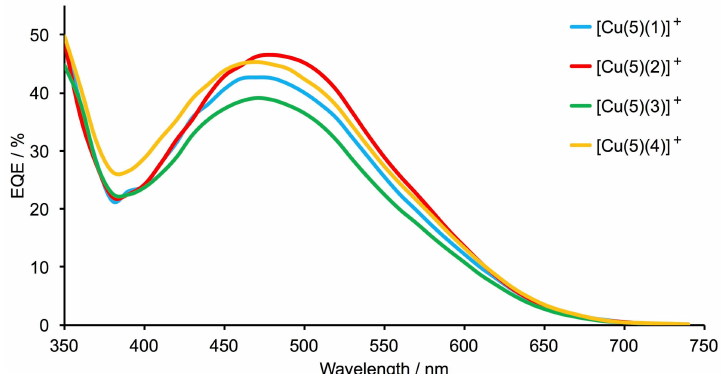
Figure 9. EQE spectra for the best performing DSSCs containing dyes [Cu( 5 )(L ancillary )] + (L ancillary = 1 – 4